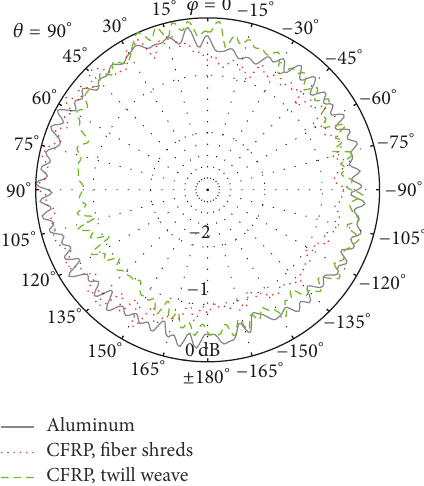
Figure 11: Monopole antenna for 5.9 GHz on a circular ground plane. Horizontal cut of the normalized measured gain pattern for polar angel 𝜃 = 90 ∘ (reprinted with permission from [34]; ©2014